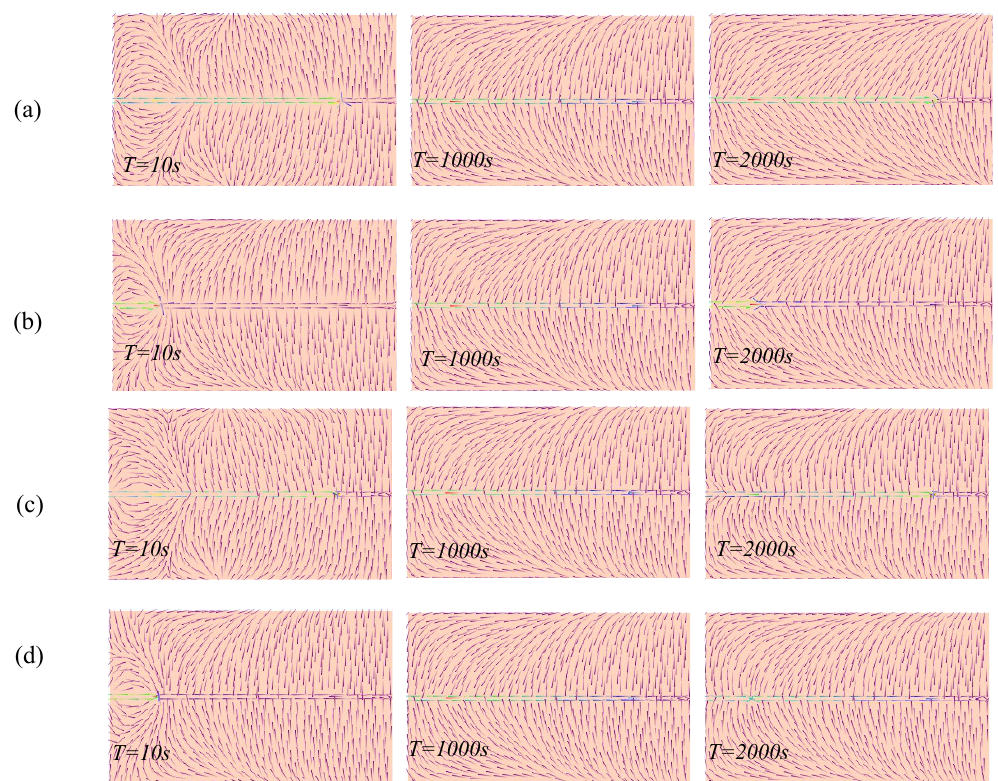
Figure 20. Flow fields regulated in conduit zone at different times. ( a ) Injected in conduit zone at the upstream location. ( b ) Injected in conduit zone at the downstream location. ( c ) Pumping in conduit zone at the upstream location. ( d ) Pumping in conduit zone at the downstream location.